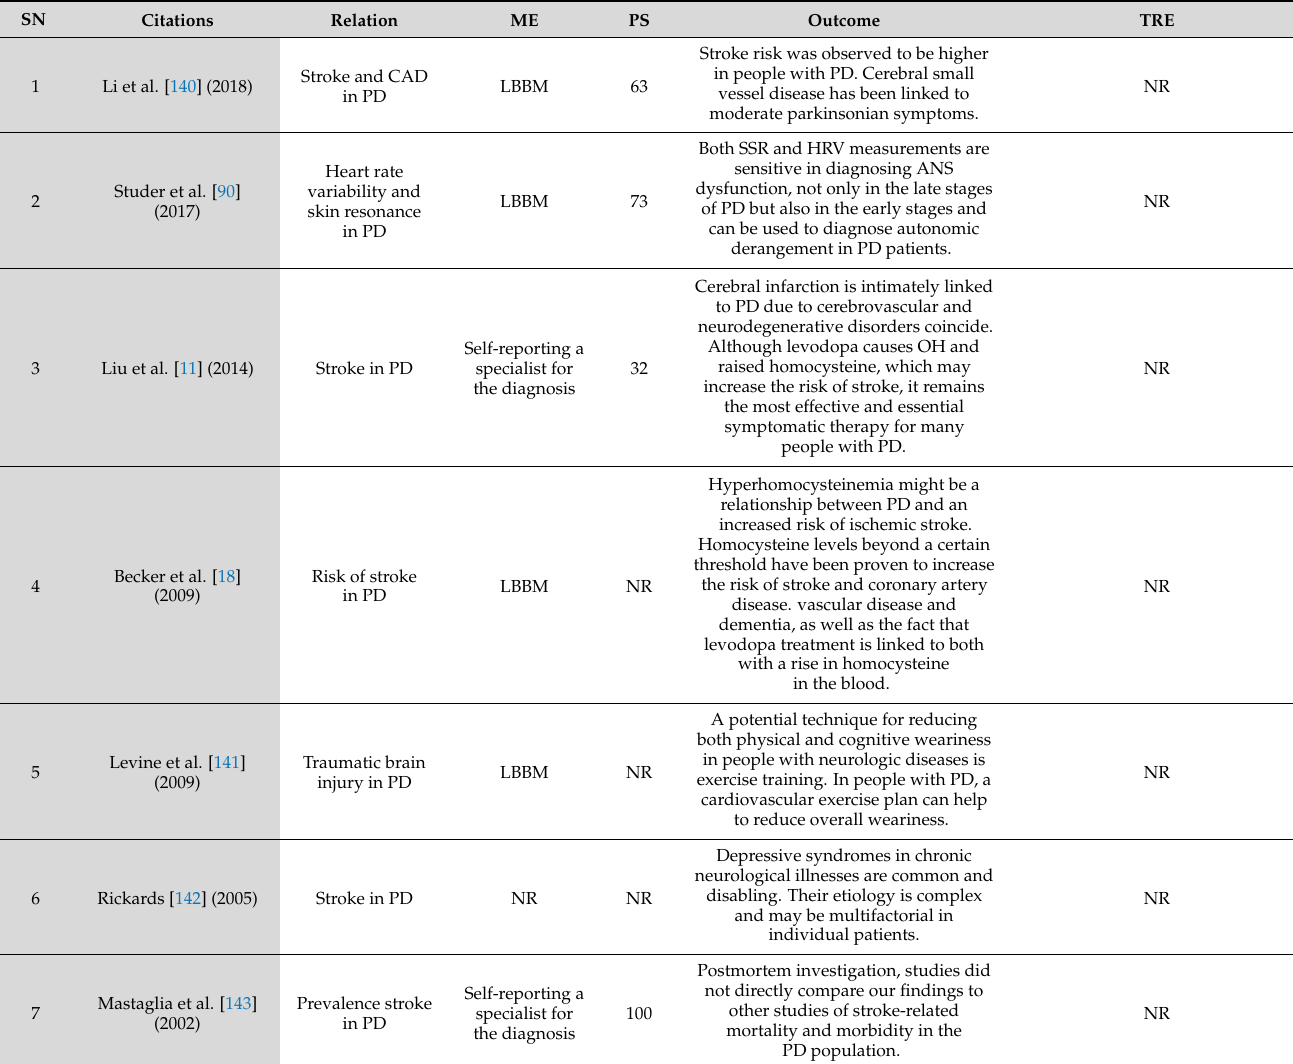
Table 2. The studies show the relationship between Parkinson’s and